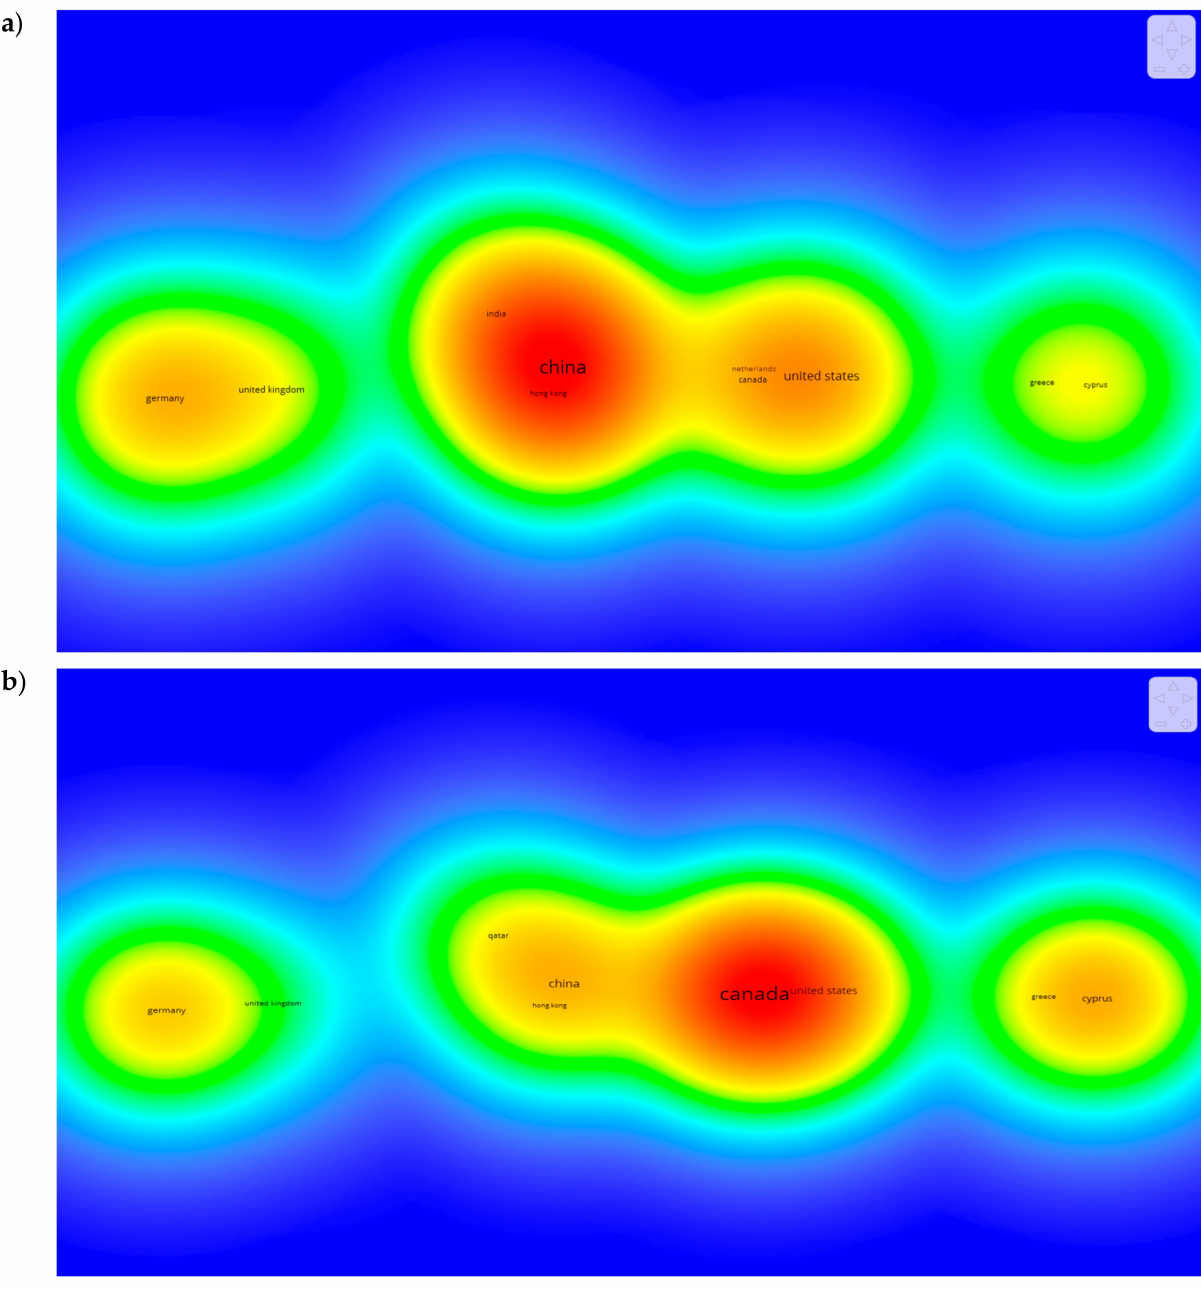
Figure 5. Density visualization of the co-authorship between countries based on ( a ) total published documents, and ( b ) number of